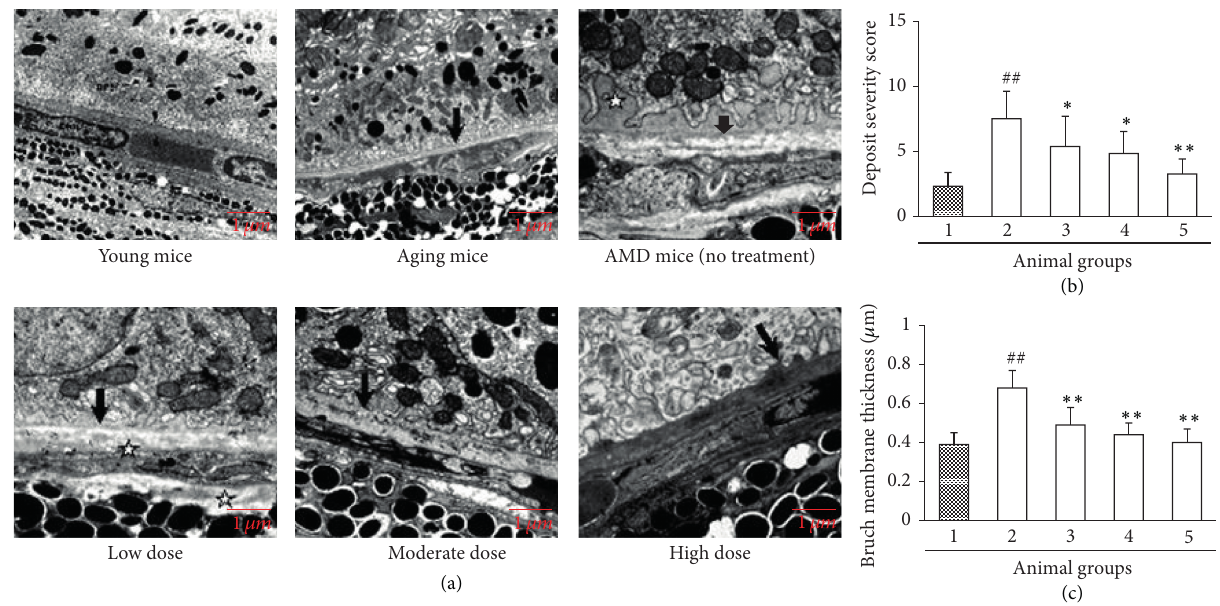
Figure1:Effectsof Fructuslycii ethanolextractonthehistopathologyinmicewithanexperimentalmodelofAMD.Miceweregrouped:group 1, aging control group (no high-fat diet plus hydroquinone, no treatment); group 2, AMD model group (with high-fat diet plus hydroquinone, no treatment); group 3, low dose group (with high-fat diet plus hydroquinone, 1.25 g/kg treatment); group 4, moderate dose group (with high- fat diet plus hydroquinone, 2.50 g/kg treatment); and group 5, high dose group (with high-fat diet plus hydroquinone, 3.75 g/kg treatment). (a) Electron microscopy examination of the eye tissues (magnification × 25000). Normal young mice (3 months old) were used as negative control. The black arrows indicate the Bruch membrane. (b) Comprehensive scoring on the severity of RPE sediment. The width and thickness of sediment were scored according to the guidelines described in Section 2. The total score = width score + 1/2 thickness score. Data are expressed as mean ± SD, ## 𝑃 < 0.01 versus group 1, ∗ 𝑃 < 0.05 versus group 2, and ∗∗ 𝑃 < 0.01 versus group 2. (c) Determination of Bruch membrane thickness. Data are expressed as mean ± SD, ## 𝑃 < 0.01 versus group 1, and ∗∗ 𝑃 < 0.01 versus group